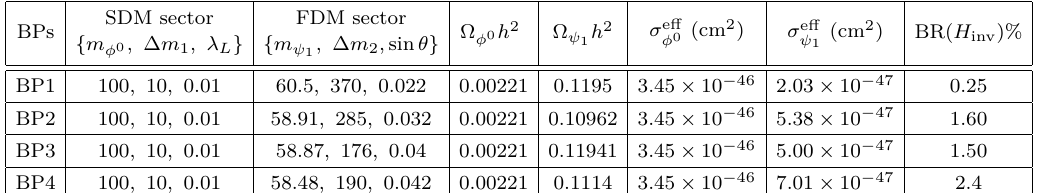
Table 2. Benchmark points of the model; contribution to relic density, spin-independent direct detection cross-section as well as that of invisible Higgs decay branching ratios of the DM compo- nents φ 0 and ψ are 1